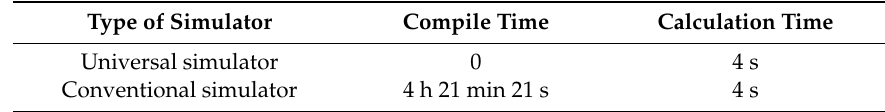
Table 2. Comparison of simulation time between the universal FPGA-based real-time simulator and Figure 10. Comparison of the simulation results between the FPGA-based real-time simulator and the conventional FPGA-based real-time PSCAD/EMTDC. ( a ) A phase current 𝐼 𝑎 of the grid-connected point of the PV in Scenario 1. ( b ) A phase current 𝐼 𝑎 of the grid-connected point of the PV in Scenario 2.